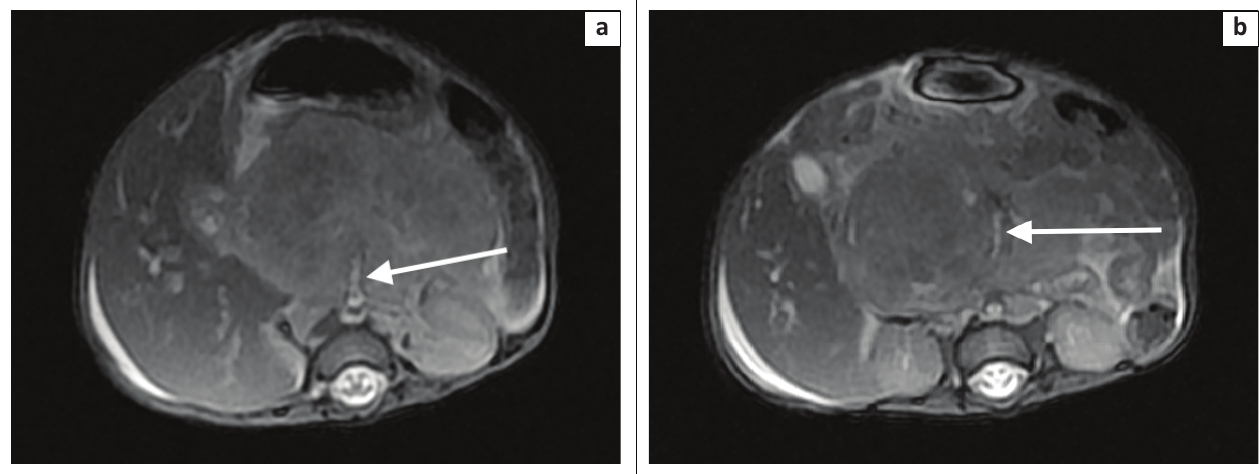
FIGURE 5: Axial T2-weighted (T2W) magnetic resonance images showing the pancreatic head mass with intermediate signal intensity and encasement of the superior mesenteric artery (white arrow) in (a) and (b) – sandwich